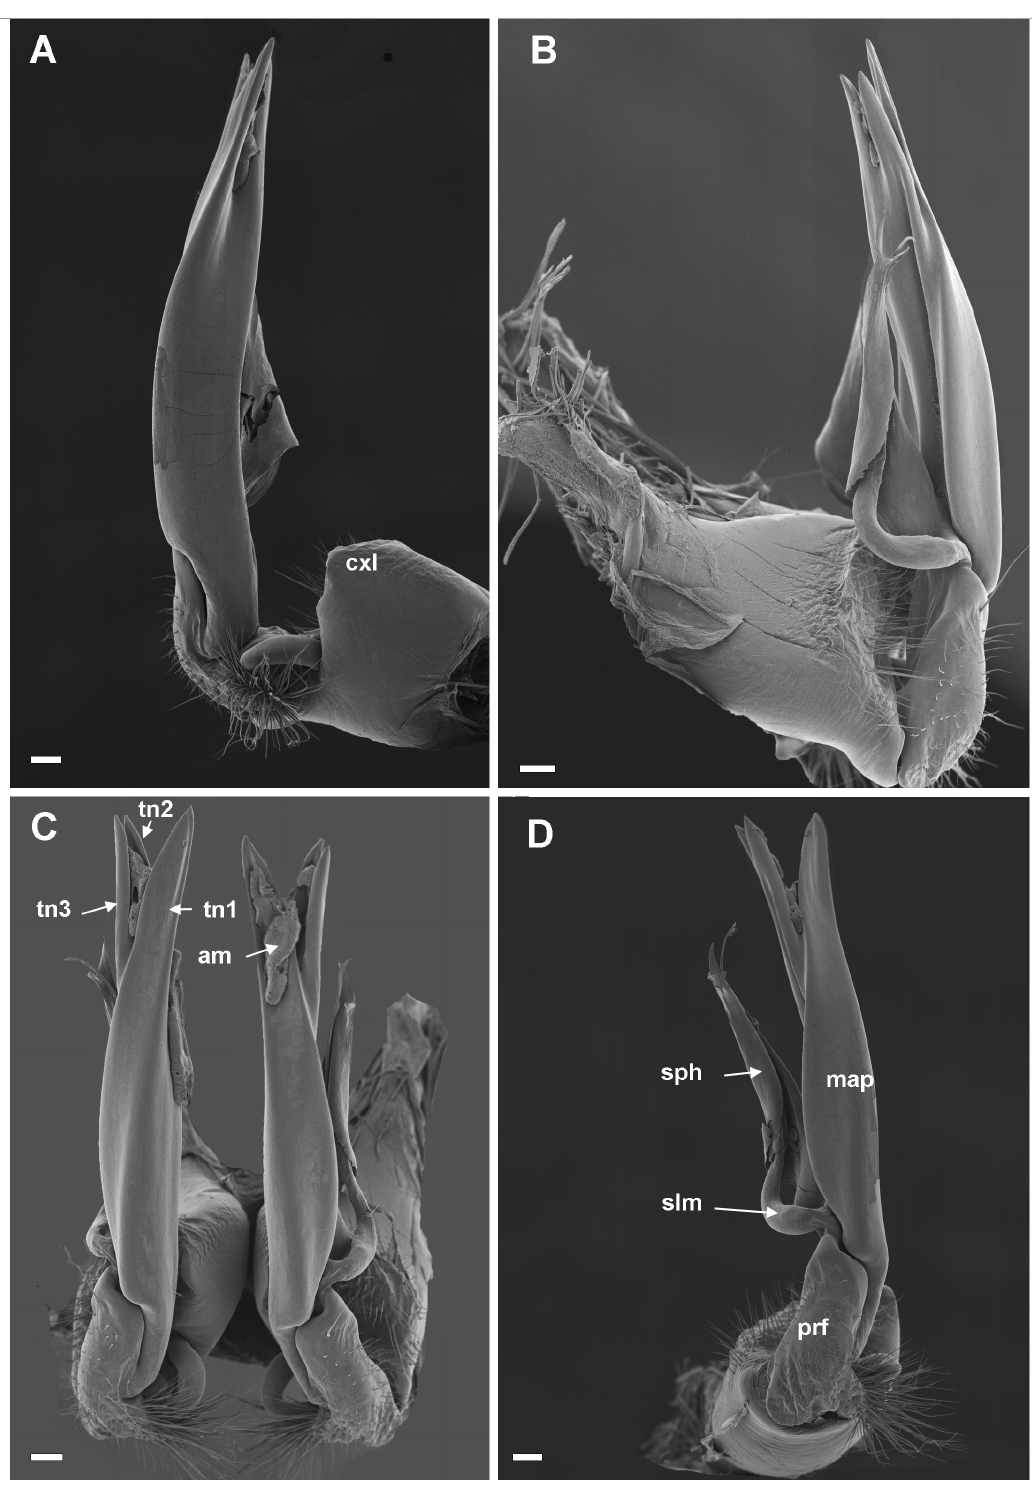
Fig. 31. Eviulisoma zebra sp. nov., paratypes. A . Paratype 1, right gonopod, mesal view. B–C . Paratype 2, gonopods. B. Lateral view. C. Ventral view; notice lumps of secretion between apical tines. D . Paratype 1, right gonopod, (latero-)ventral view. Abbreviations: am = amorphous mass; cxl = coxal lobe; map = mesal acropodital process; sph = solenophore; slm = solenomere; tn1 , tn2 , tn3 = apical tines of process map . Scale bars: 0.1